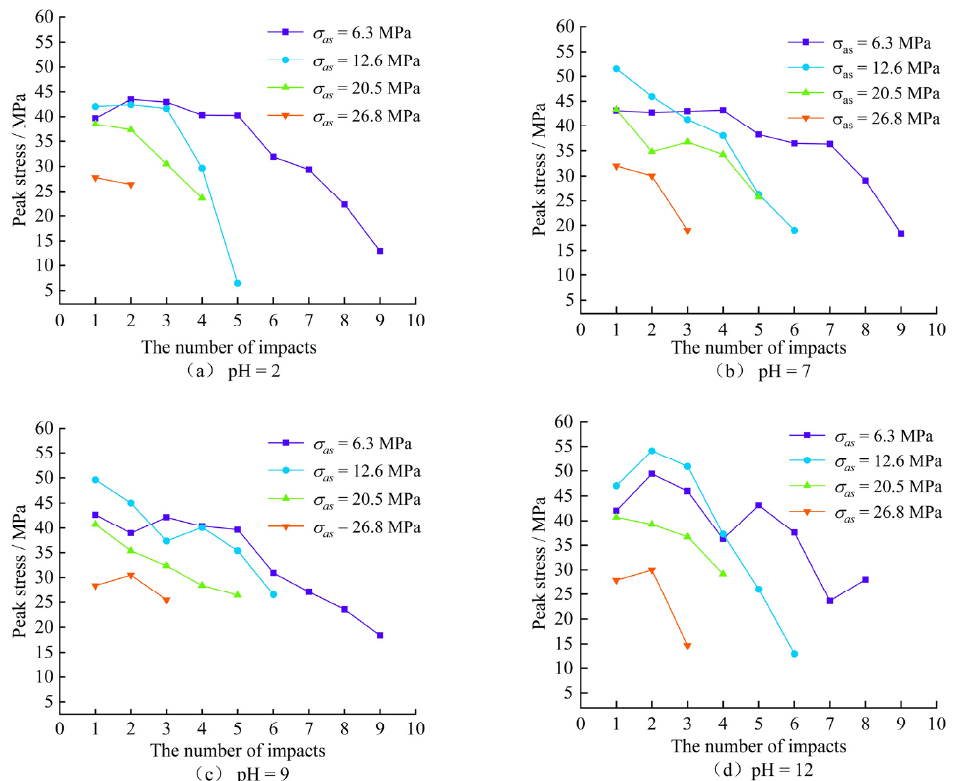
Figure 7. Relationship between peak stress and number of impacts. ( a ) pH = 2; ( b ) pH = 7; ( c ) pH = 9; ( d ) pH =